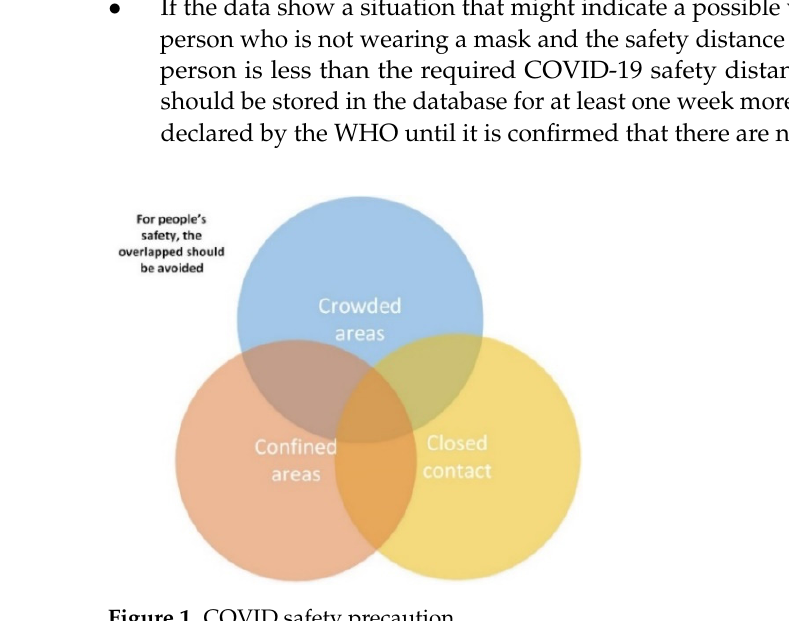
Figure 1. COVID safety precaution.